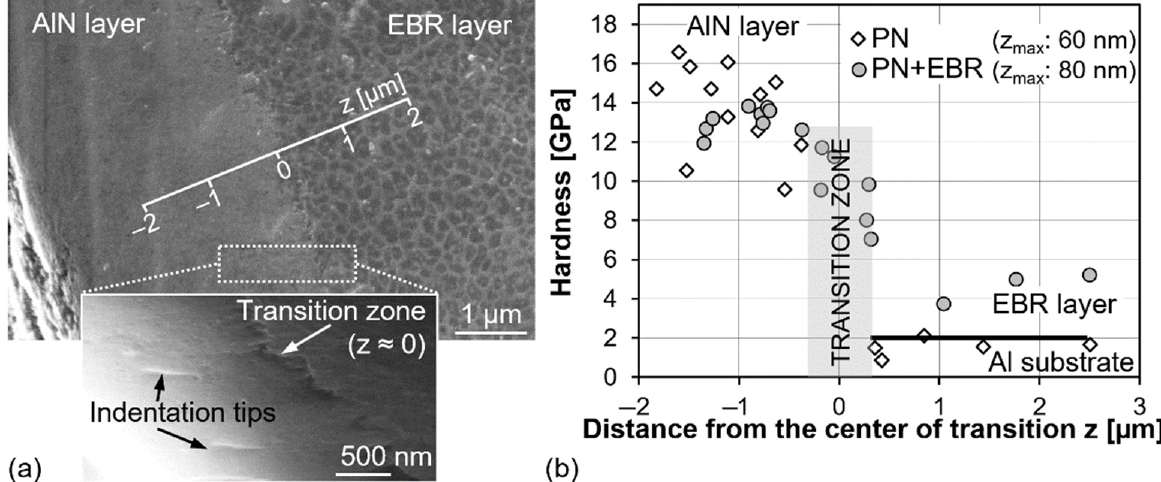
Figure 9. Nanoindentation hardness measurements in displacement-controlled mode with a maximum depth of z max = 60 nm (PN) and of z max = 80 nm (PN + EBR): ( a ) SEM image with indentation tips (exemplary), ( b ) hardness-depth profile (z = 0 marks the transition zone between AlN and EBR layer).